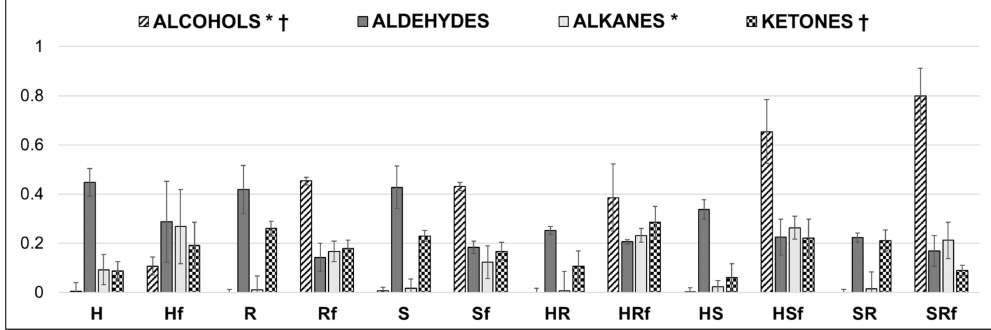
Figure 1. Sums of groups of molecules from not fermented and from means of fermented. p < 0.05; † = alcohols vs alkanes not significant; * = alcohols vs ketones not significant. H = hemp drink; Hf = fermented hemp drink; R = rice drink; Rf = fermented rice drink; S = soy drink; Sf = fermented soy drink; HR = hemp / rice drink; HRf = fermented hemp / rice drink; HS = hemp / soy drink; HSf = fermented hemp / soy drink; SR = soy / rice drink; SRf = fermented soy / rice drink. Y axis reports normalized (mean centering method) values of volatile organic compounds (VOCs)